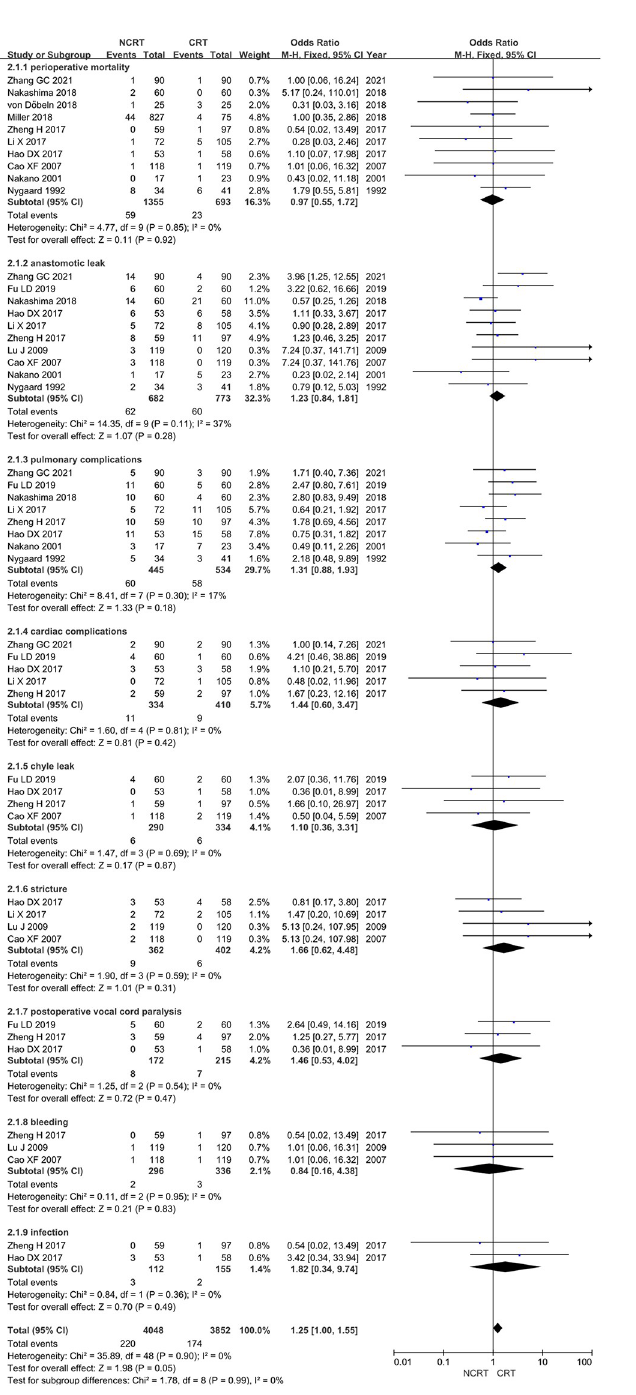
Fig 6. Forest plot for postoperative complications of NCRT group and NCT group.